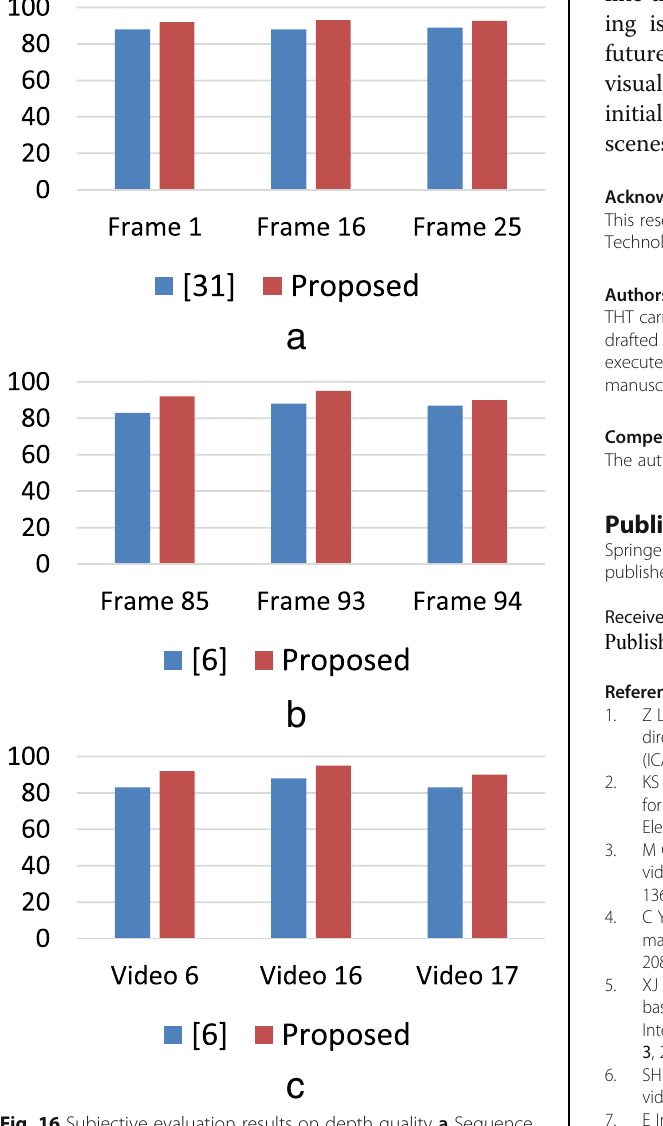
Fig. 16 Subjective evaluation results on depth quality a Sequence Kendo in [31]. b Sequence_1 in [6]. c Three sequences in